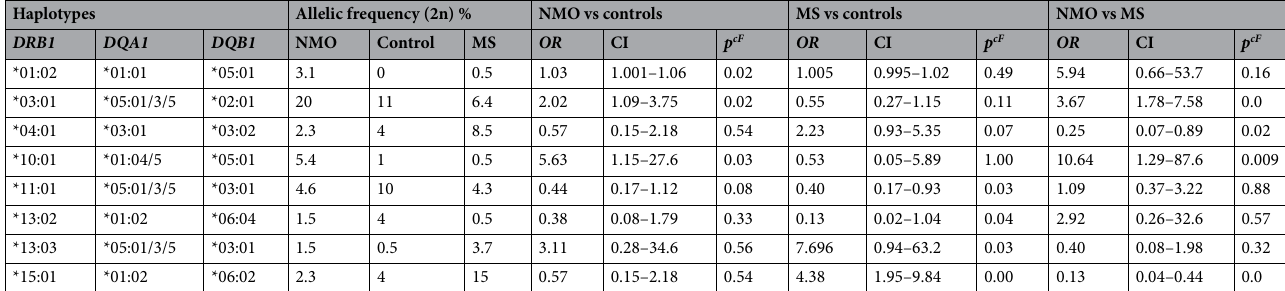
Table 6. Haplotypes identified in association with NMO and MS, and comparison of NMO and MS groups. MS, Multiple Sclerosis; NMO, Neuromyelitis Optica; OR , Odds Ratio ; CI, Confidence Interval; p cF , p corrected by Fisher’s exact test. Adapted from Alvarenga et al. (Table 2) 33